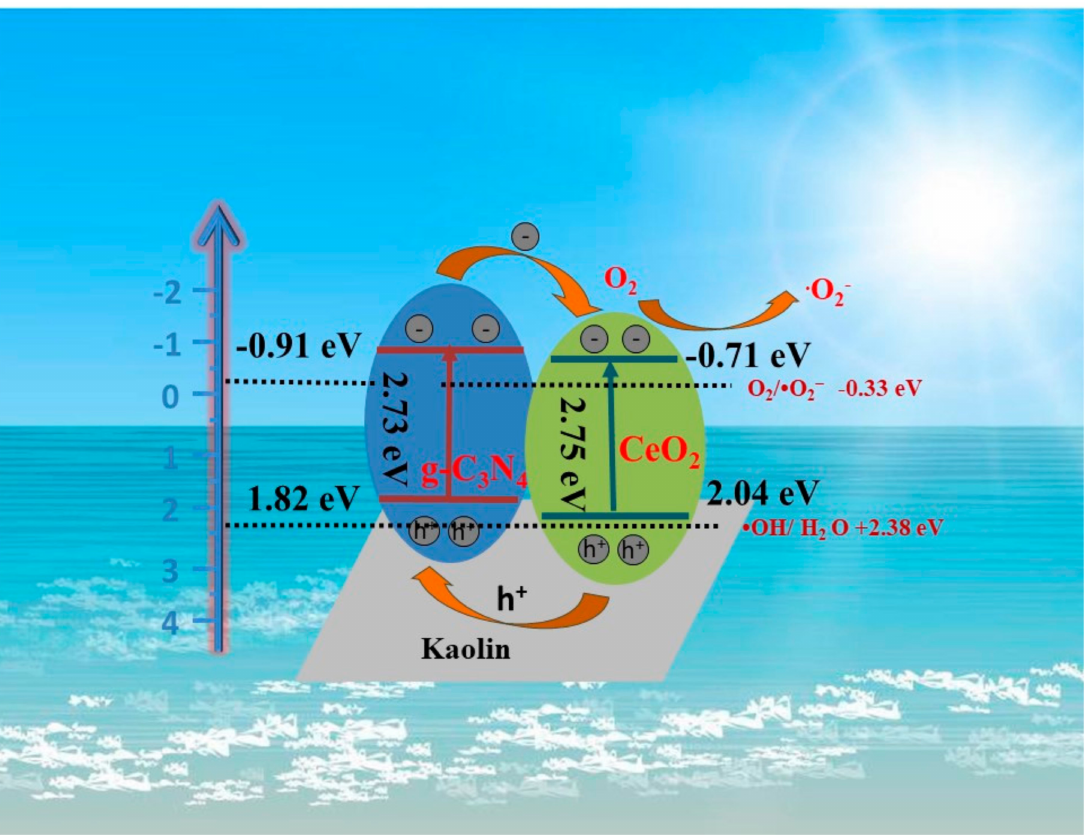
Figure 10. Schematic representation of electron transfer on the surface of the kaolin / CeO 2 / g- C 3 N 4